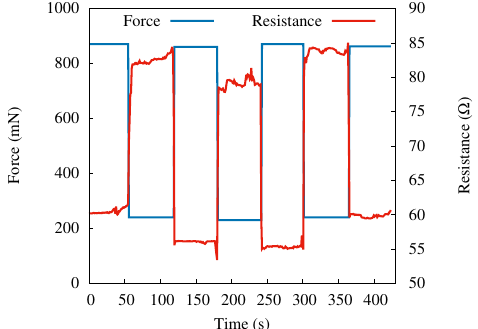
Figure 6. SiNWs PZR response due to repeated load–unload forces in real time for sample D. Hydrogenation (exposure to hydrogen plasma) is widely used in the electronic in- dustry to increase the mobility of charge carriers in semiconductors. It neutralizes deep and shallow defects and charged surface states [31,32]. Because the PZR effect has been attributed to surface states, we applied a hydrogenation treatment in order to explore the origin of the PZR effect in SiNWs. For hydrogen plasma treatment, we used a custom-built inductively coupled discharge setup with cylindrical geometry (290 mm long quartz tube with a diameter of 34 mm). The quartz tube was held inside a circular copper inductive coil with a diameter of 54 mm. A radio-frequency power generator CERSAR (c) (13.56 MHz) source coupled with an impedance-matching unit was utilized. For hydrogenation, a